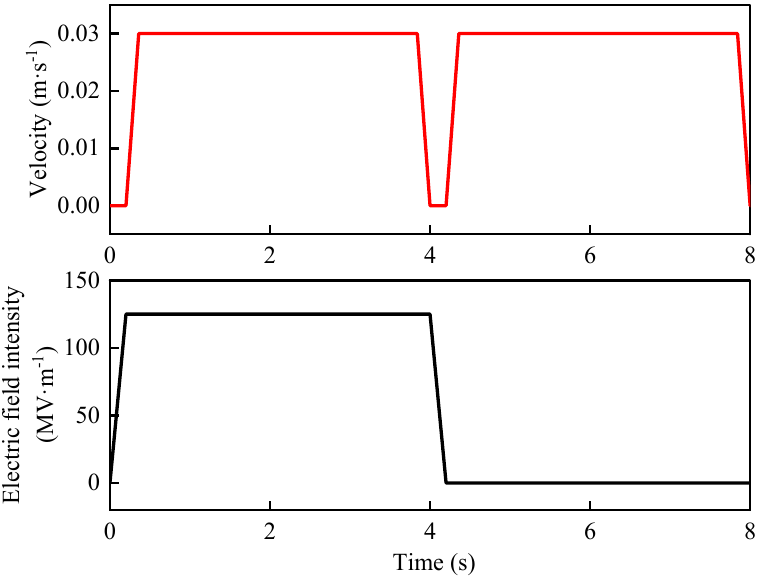
Figure 15. Changing trend of electric field and fluid velocity in one cycle.